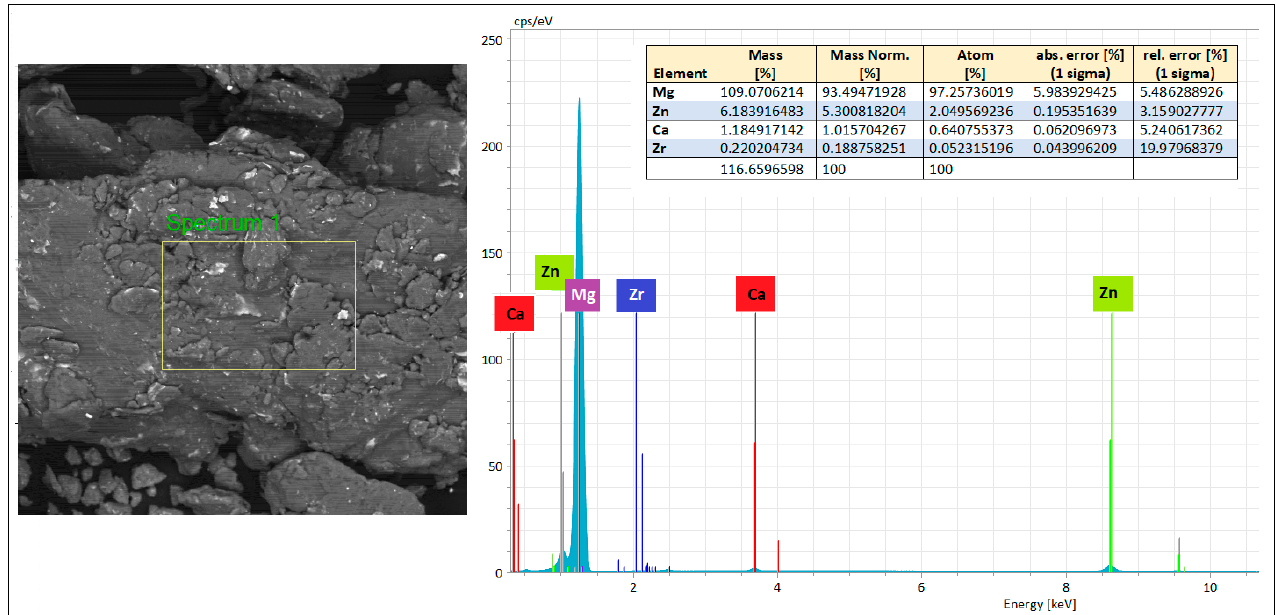
Figure 11. The SEM ‐ EDS image and compositional results for the Mg ‐ 6Zn ‐ 0.8Ca ‐ 0.5Zr alloy after Figure 11. The SEM-EDS image and compositional results for the Mg-6Zn-0.8Ca-0.5Zr alloy after mechanical alloying with 300 rpm/28 h/10:1. mechanical alloying with 300 rpm/28